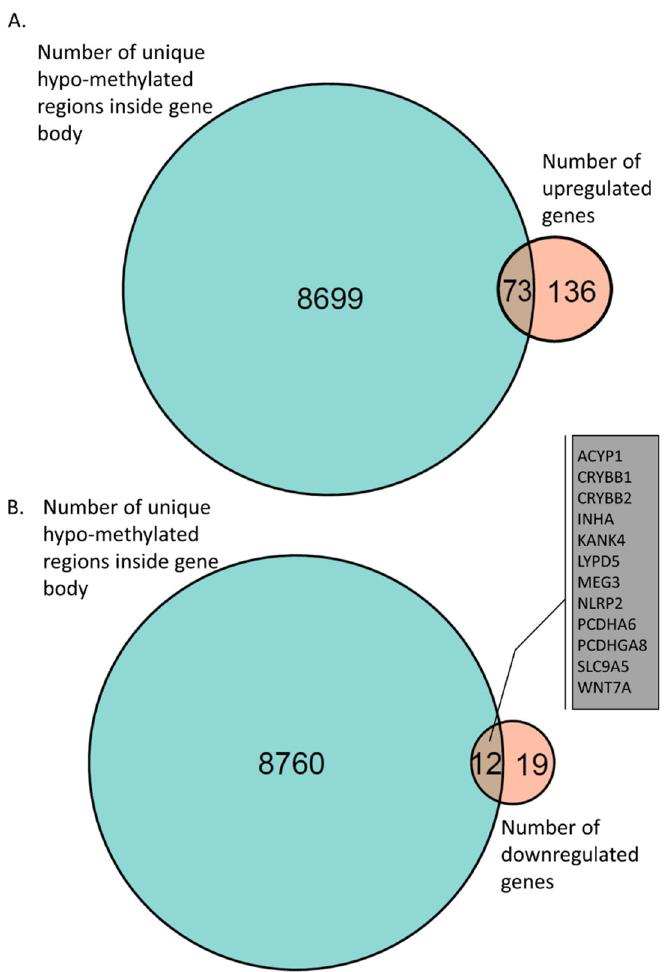
Figure 5. Venn diagram of gene-body hypo-methylation and gene expression. ( A ) A total of 73 genes were identified with a hypo-methylated region inside the gene body that were found in AS-derived iPSC neurons. ( B ) A total of 12 genes were identified with hypo-methylated regions inside their gene bodies that were found to be downregulated in AS-derived iPSC neurons.